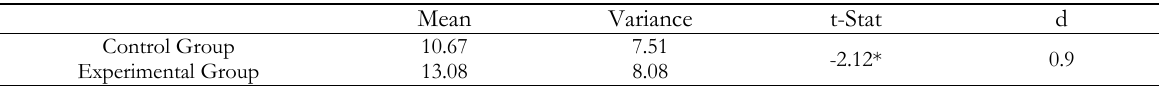
Table 4. Comparison on the gain scores of the two groups Mean Variance t-Stat